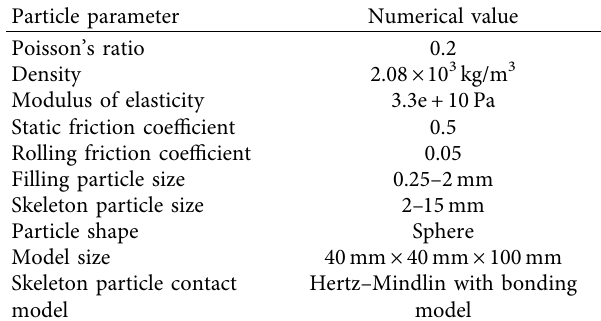
Table 1: Particle parameter